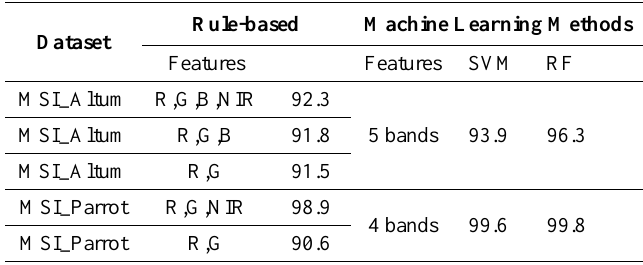
Table 3 Testing accuracies (%) of classifying MSI datasets using